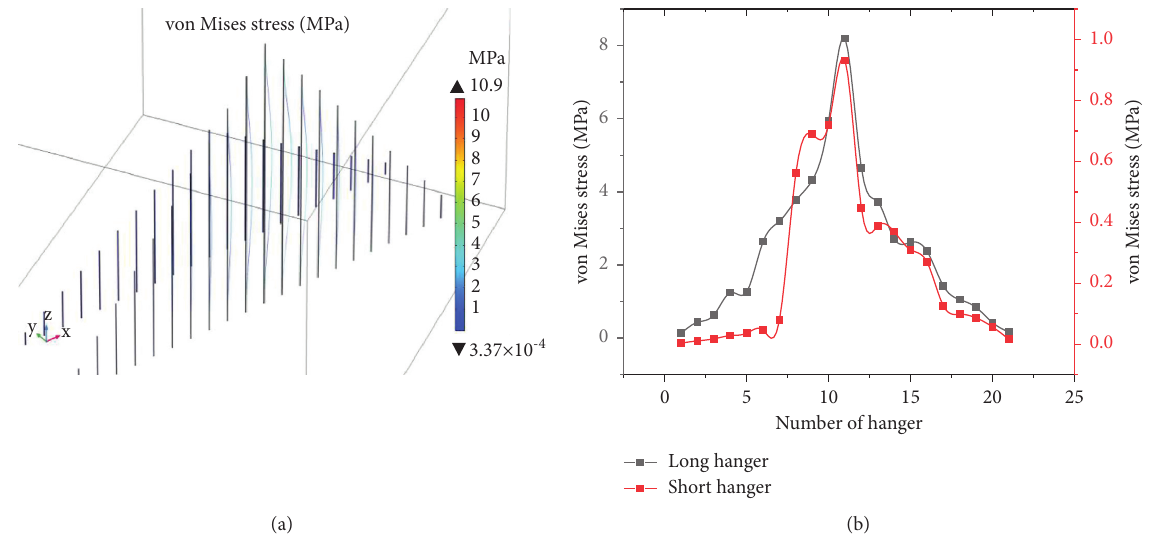
Figure 6: Stress distribution of hangers (wind direction � 30 ° /150 ° ).